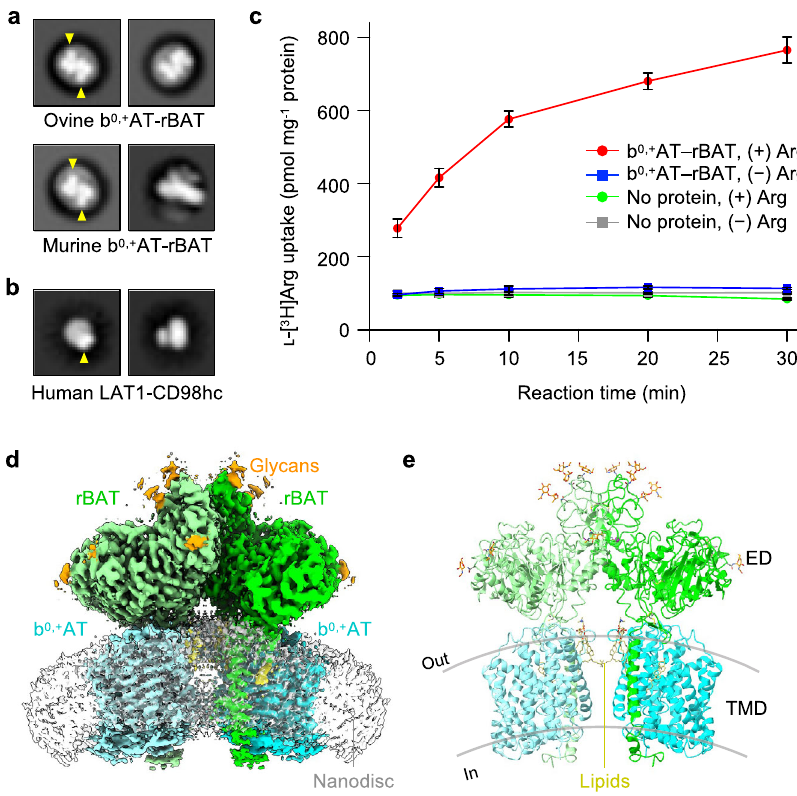
Fig. 1 Structural and biochemical characterization of b 0, + AT – rBAT in a lipid environment. a 2D class averages of ovine and murine b 0, + AT – rBAT imaged by negative-stain electron microscopy. The rBAT ectodomains are marked by yellow arrows. b 2D class averages of LAT1 – CD98hc. The CD98hc ectodomain is marked by a yellow arrow. c Uptake of ʟ -[ 3 H]Arg by ovine b 0, + AT – rBAT reconstituted into proteoliposomes. Proteoliposomes were pre-loaded with either 1 mM or no ʟ -Arg. Control experiments were performed with protein-free liposomes. Values are mean ± SEM. n = 3 technical replicates. d Cryo-EM map of the super-dimeric b 0, + AT – rBAT complex in lipid nanodiscs. Map densities corresponding to different chains and chemical identities are colored as follows: rBAT (green and light green), b 0, + AT (cyan and light cyan), nanodisc (translucent white), lipids (yellow) and N-linked glycans (orange). e Ribbon diagram of b 0, + AT – rBAT. The position of the lipid bilayer is based on the lipid-solvent boundaries calculated by the PPM server